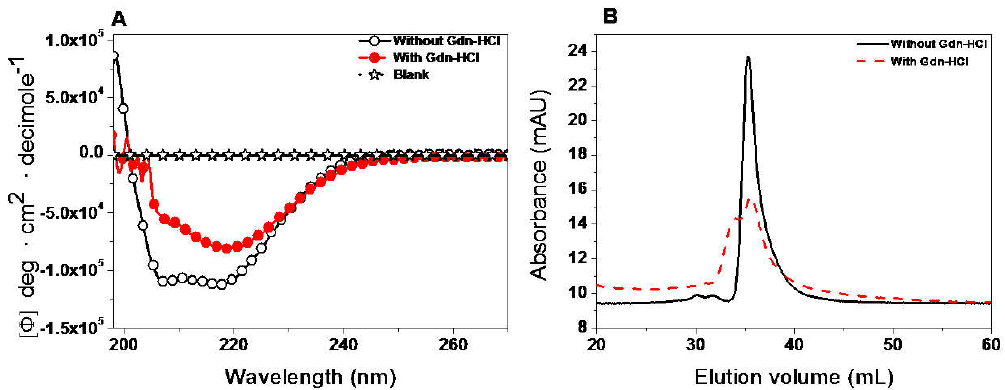
Figure 8. Evaluation of protein stability. Spectroscopic characterization of recombinant G6PD protein from G . lamblia . ( A ) Far-ultraviolet (UV) CD spectra of protein in absence or presence of 0.45 M Gdn-HCl. The protein concentration was 0.4 mg/mL and incubated for two hours at 37 °C before being measured by CD. For both trials, the spectra of blanks were subtracted from those that contained the protein. ( B ) Gel filtration chromatography used to evaluate the protein stability of native G6PD::6PGL dimers in absence or presence of 0.45 M Gdn-HCl. The enzyme (0.4 mg/mL) was incubated at 37 °C for two hours and then loaded onto a Shodex Protein ® KW-802.5 column.